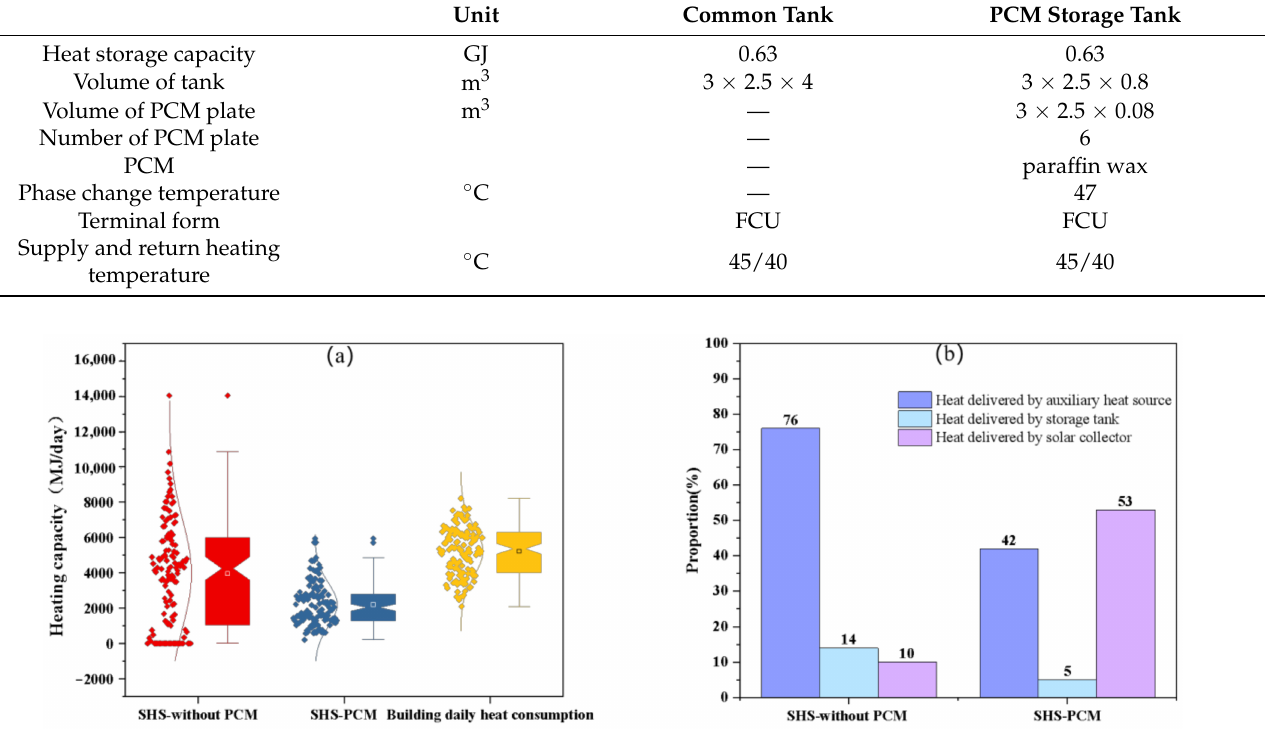
Figure 10. ( a ) Daily heat delivered by the AHS of the SHS-PCM and the SHS-without PCM, as well as daily heat consumption of the building; ( b ) the proportion of heat delivered by AHS, heat storage tank, and solar collector in the SHS-without PCM and the